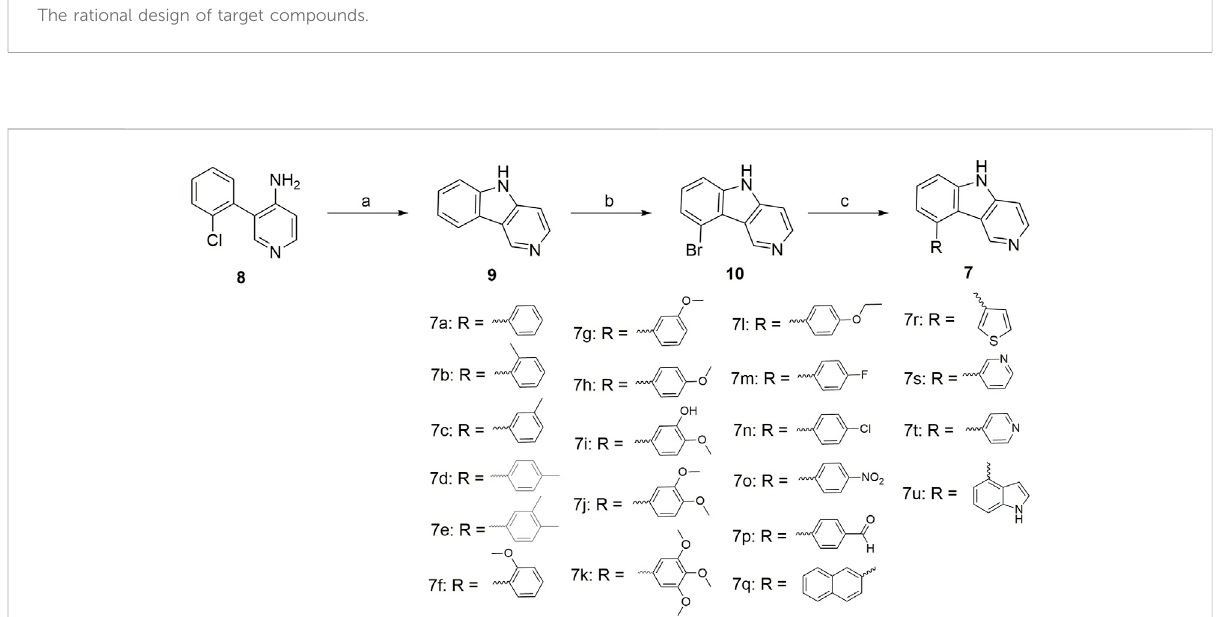
SCHEME 1 Reagents and conditions: (a) potassium tert-butoxide, dry DMSO, 130 ° C, 24 h; (b) N -bromosuccinimide (NBS), DMF, r.t., 12 h; (c) Substituted phenylboronic acid,